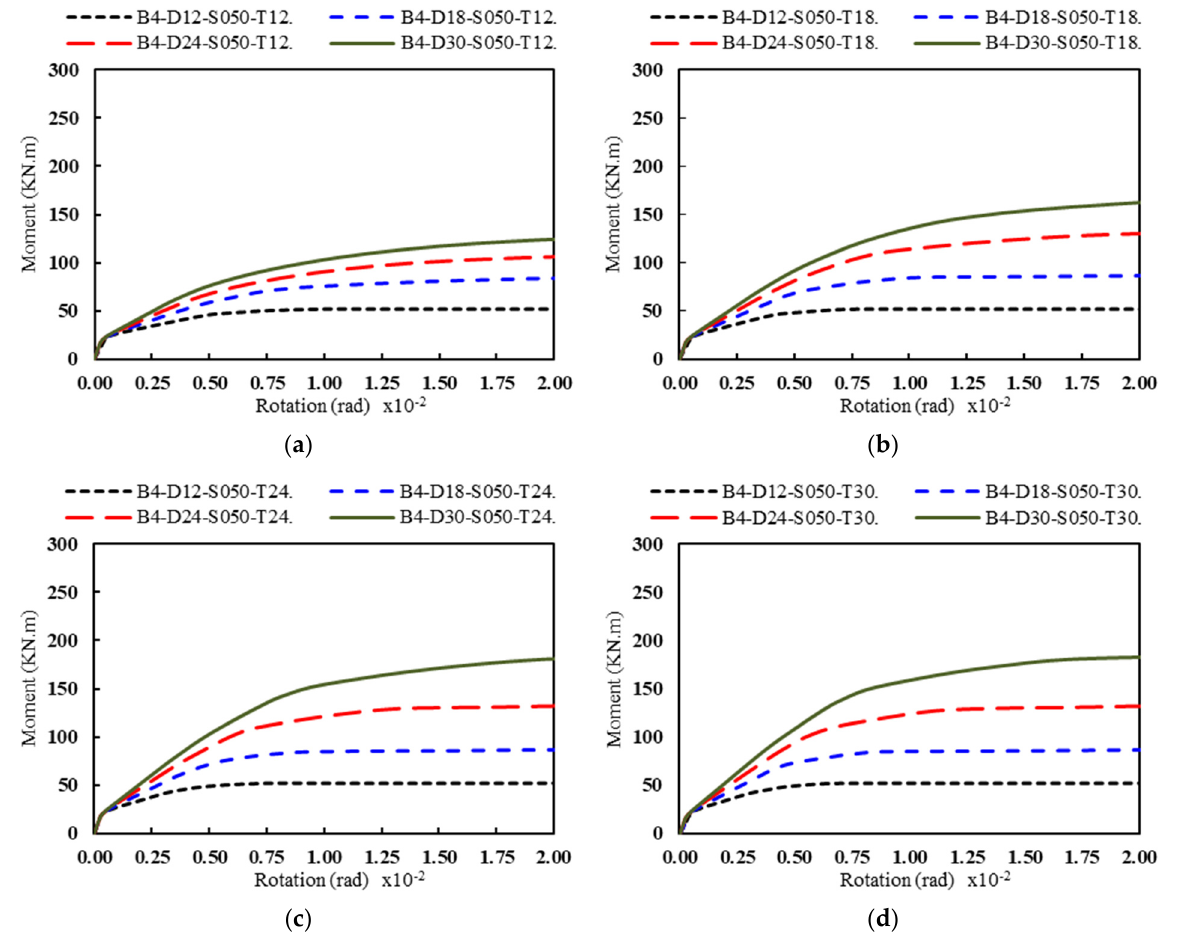
Figure 14. Effect of the anchor bolt diameter (D) on rotational stiffness for different base plate thickness (T): ( a ) T = 12 mm, ( b ) T = 18 mm, ( c ) T = 24 mm, and ( d ) T = 30 mm (Four anchor bolts and S = 50 mm).